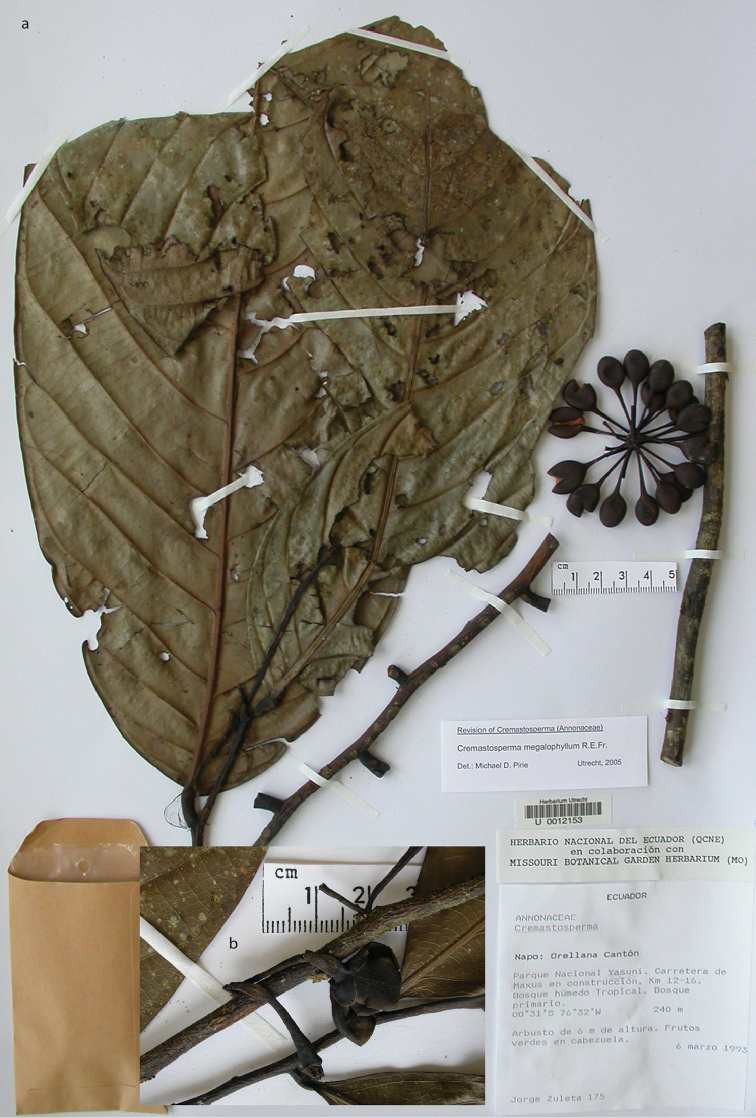
Cremastospermamegalophyllum R.E.Fr. a fruiting specimen b flower buds (aZuleta 175bPalacios 3270).